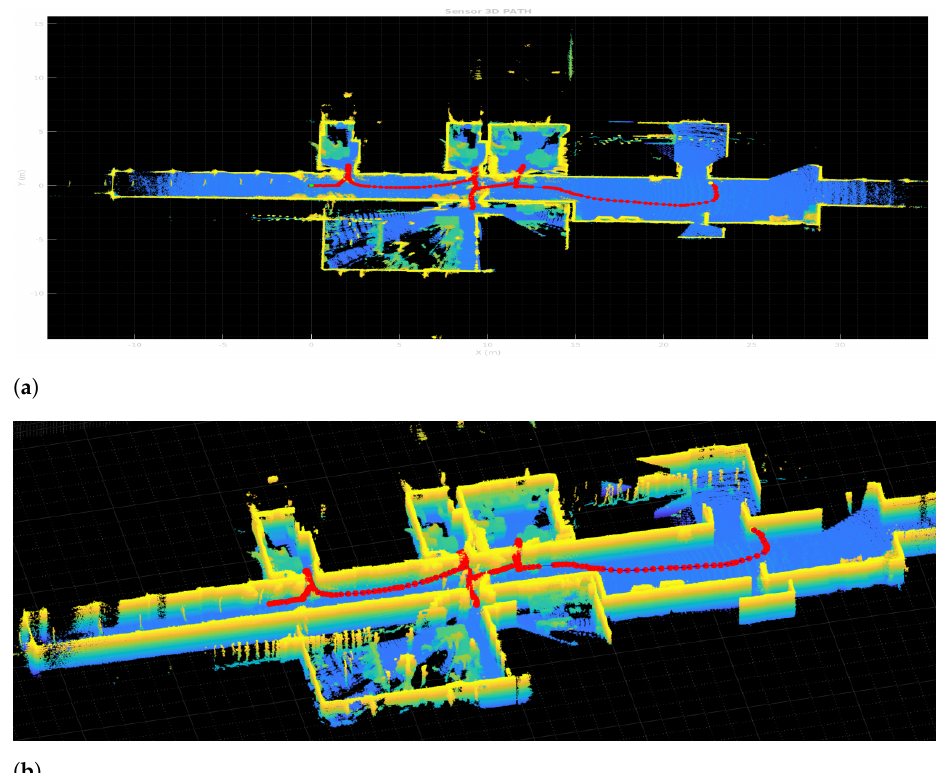
Figure 9. 3D Harmony-SLAM. ( a ) Top view. ( b ) Side view.